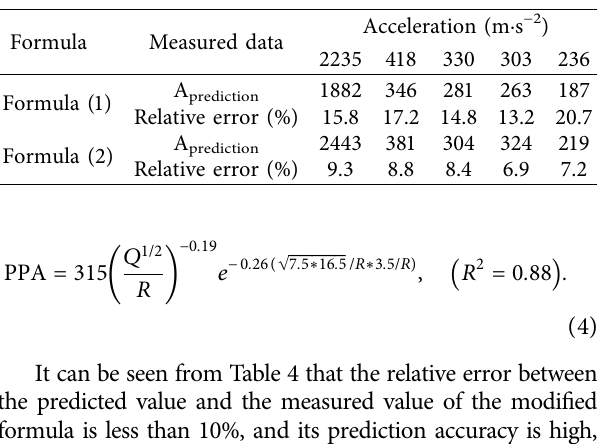
Table 4: Comparison between measured vibration velocity and predicted vibration velocity in the near blasting area of Zhaitang